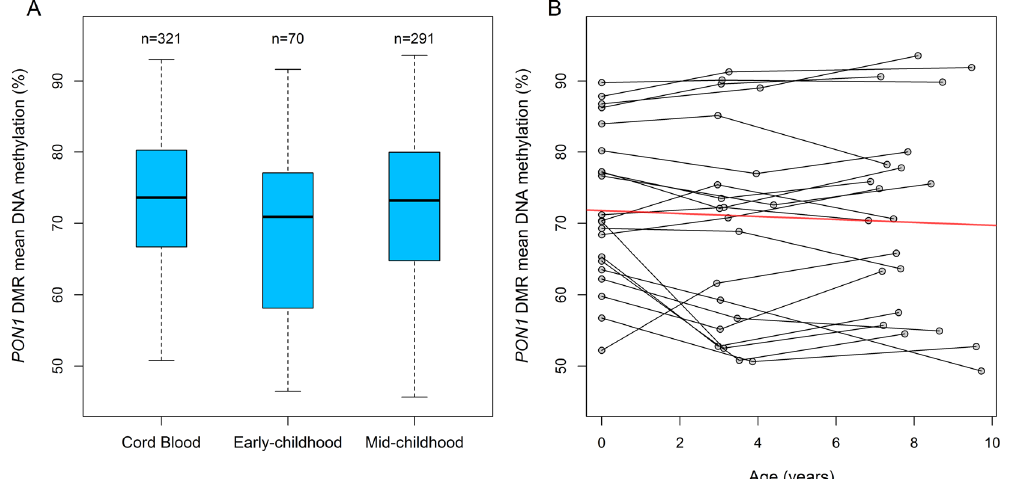
Figure 7. Mean methylation levels of the DMR in PON1 measured at three time points: ( A ) Distribution of mean methylation levels among all individuals and ( B ) individual trajectories for participants that were repeatedly measured during the study period (n = 21) and fitted regression line